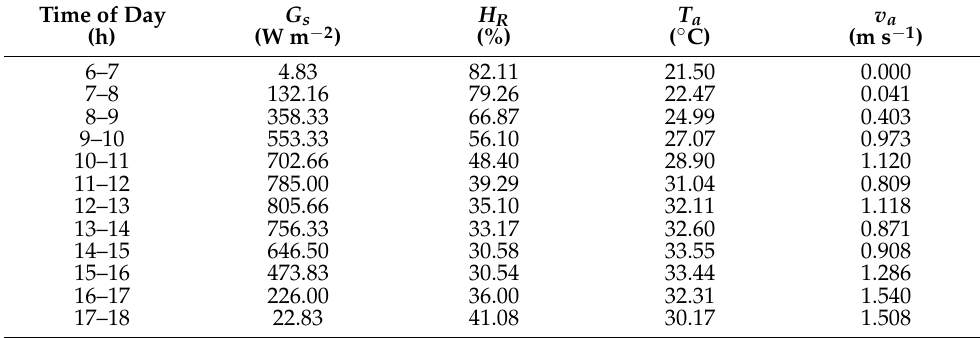
Table A3. Weather data set for the autumn day (20 October 2019) used in the PVT-RO simulations. Time of Day